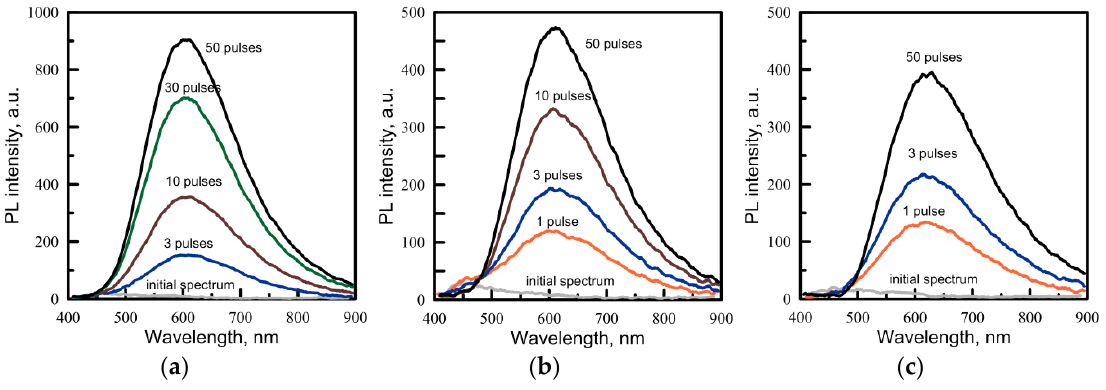
Figure 3. The evolution of PL emission spectra of Cd(C 12 H 25 S) 2 powder irradiated with various numbers of UV laser pulses of 266 nm wavelength. The laser fluence is 150 mJ/cm 2 ( a ), 190 mJ/cm 2 ( b ), 290 mJ/cm 2 ( c ).